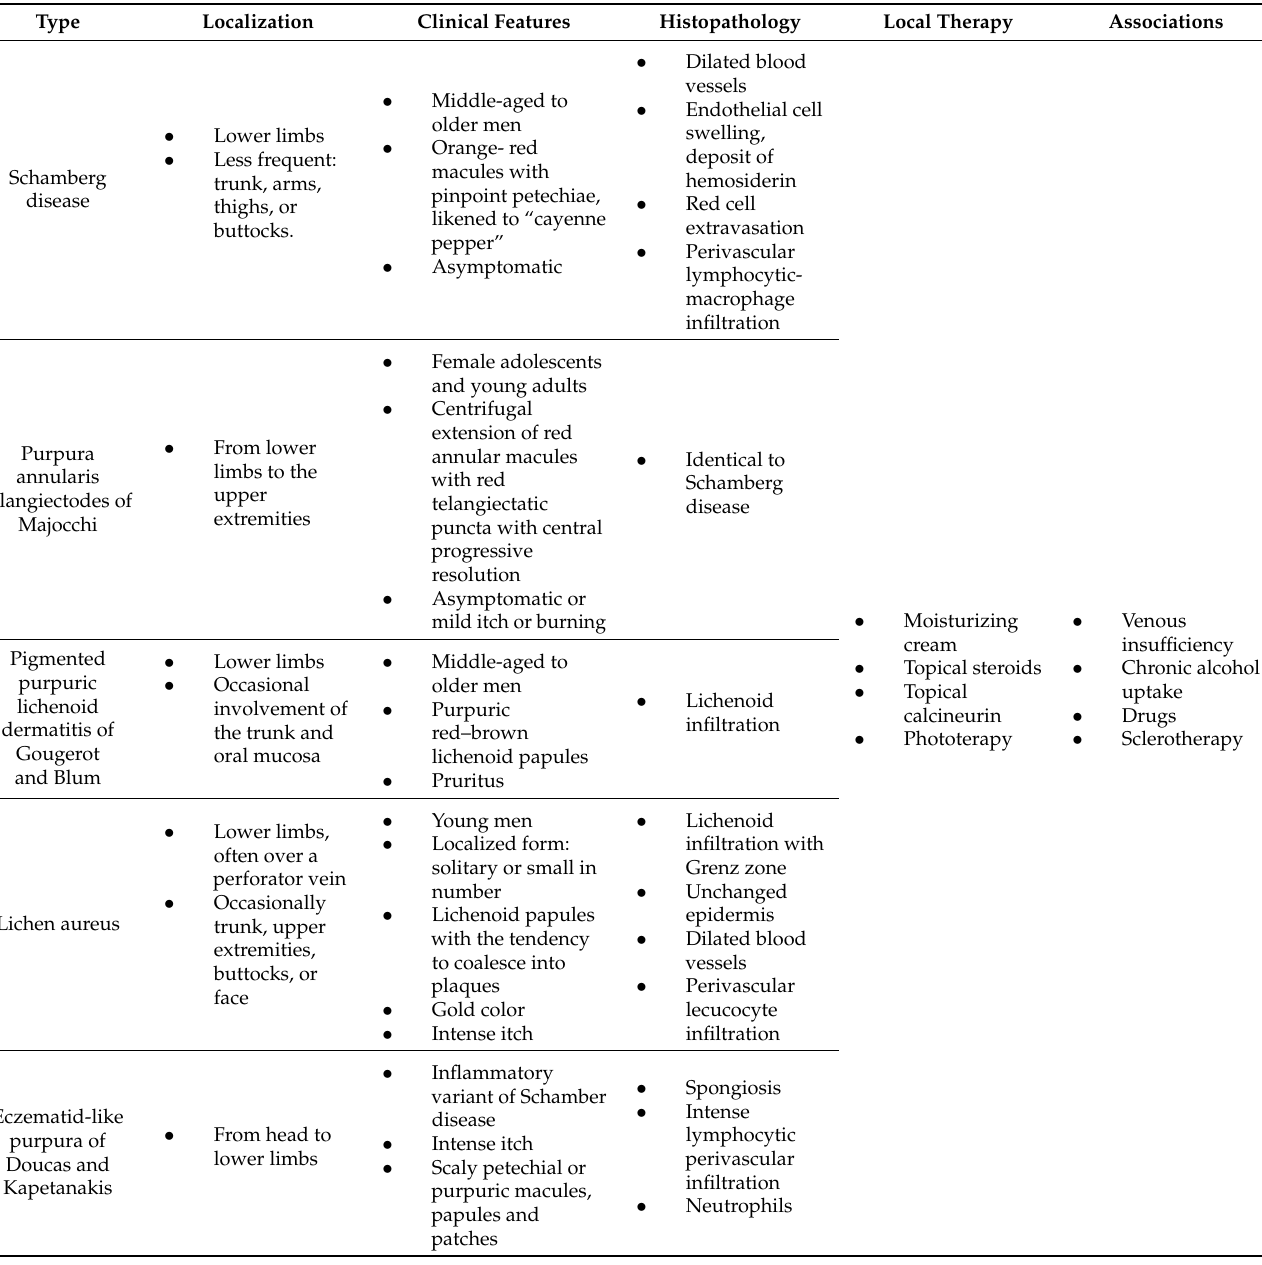
Table 2. Distinctive features of pigmented purpuric